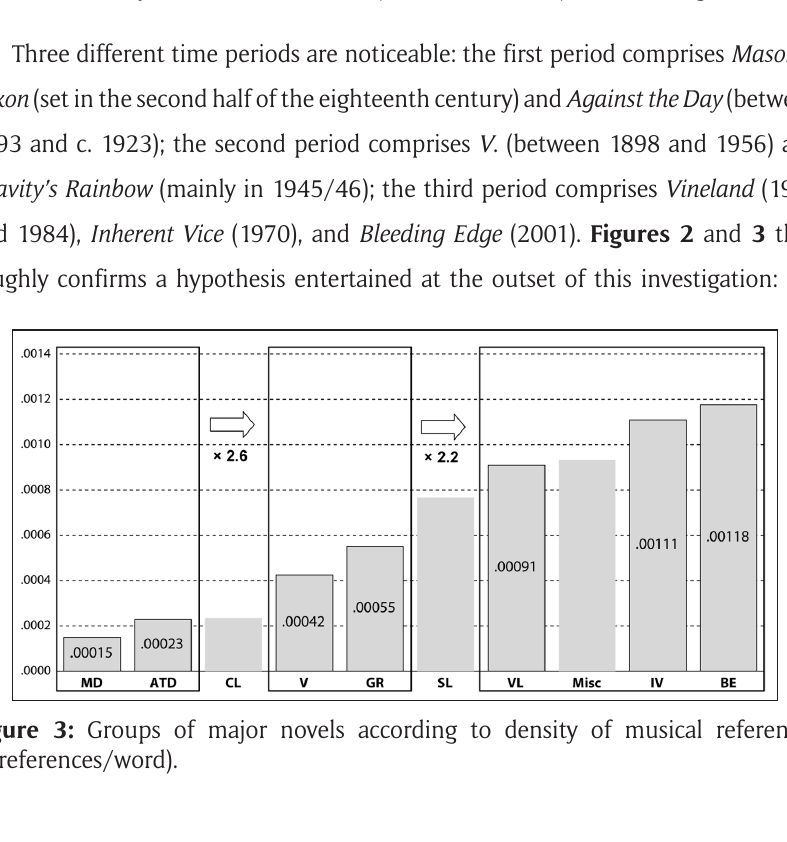
Figure 2: Density of musical references (references/words), in ascending order.